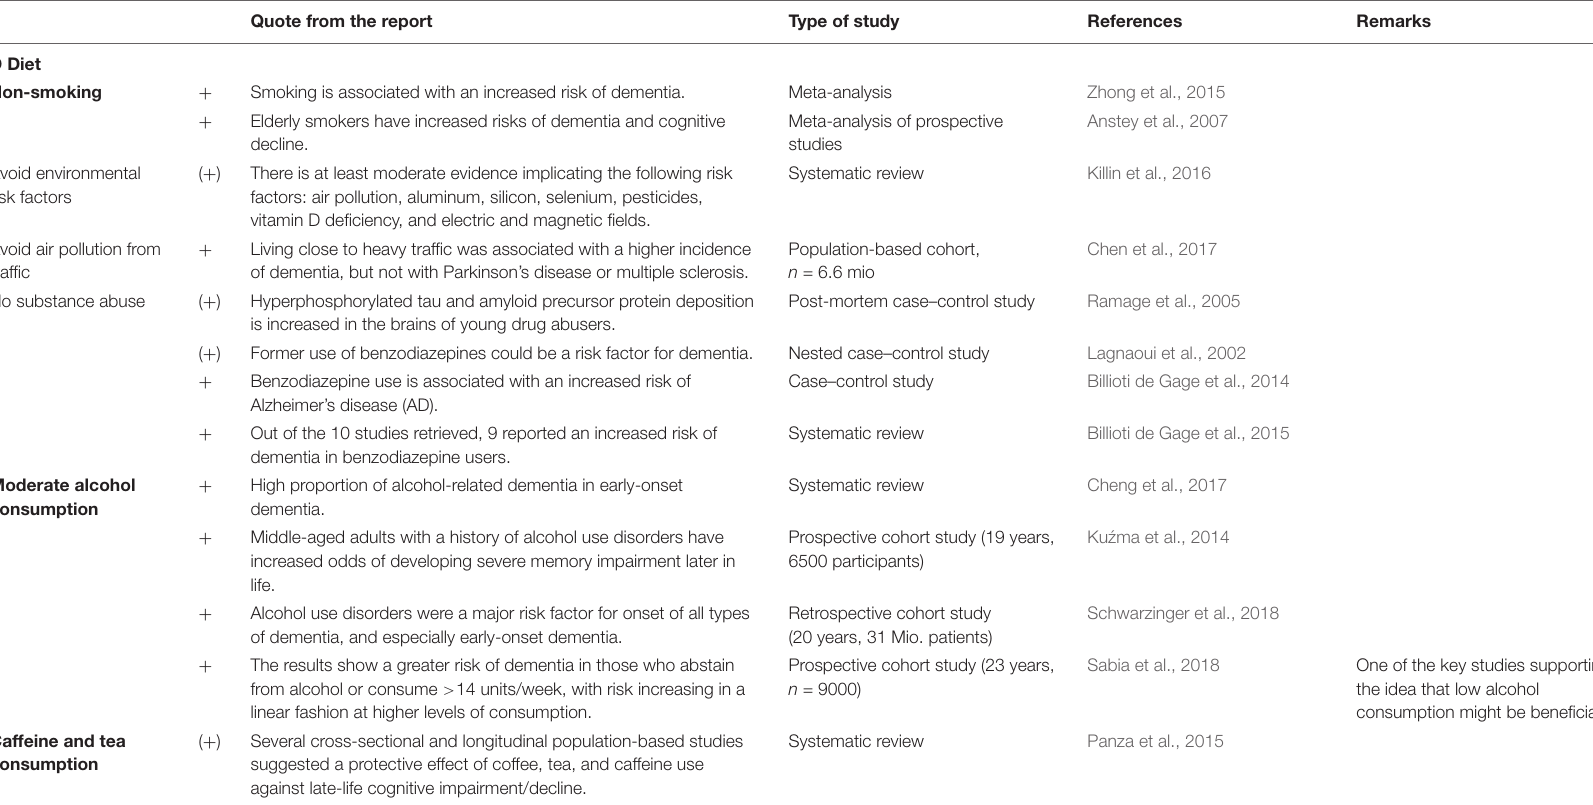
TABLE A1 | The table lists potential lifestyle resilience factors for neurodegenerative disease, independent of whether the cited publications are referring to the risk or resilience side of the